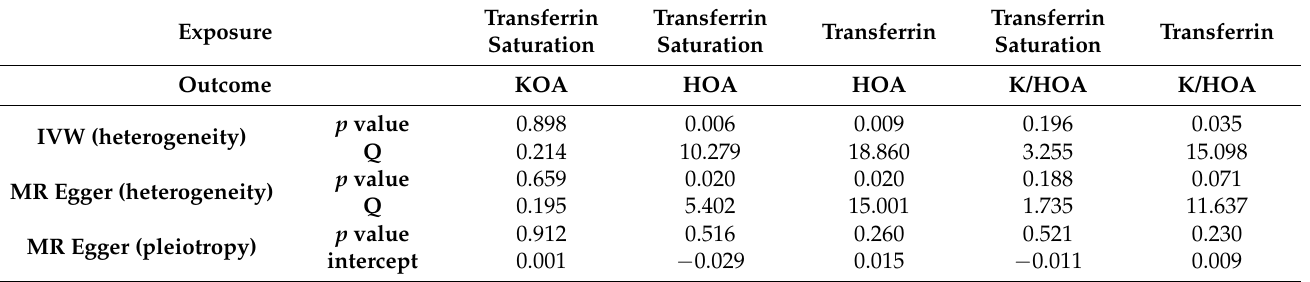
Table 2. Sensitivity analysis of the Mendelian randomization (MR) analysis results of osteoarthritis (OA) and iron status